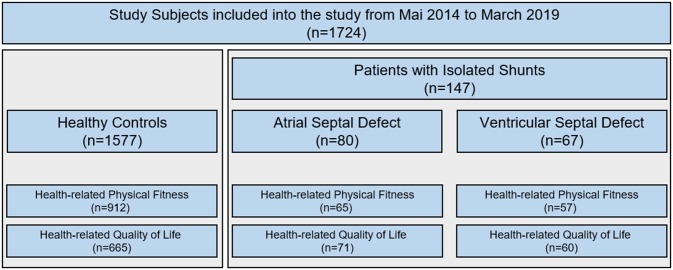
Patients inclusion.